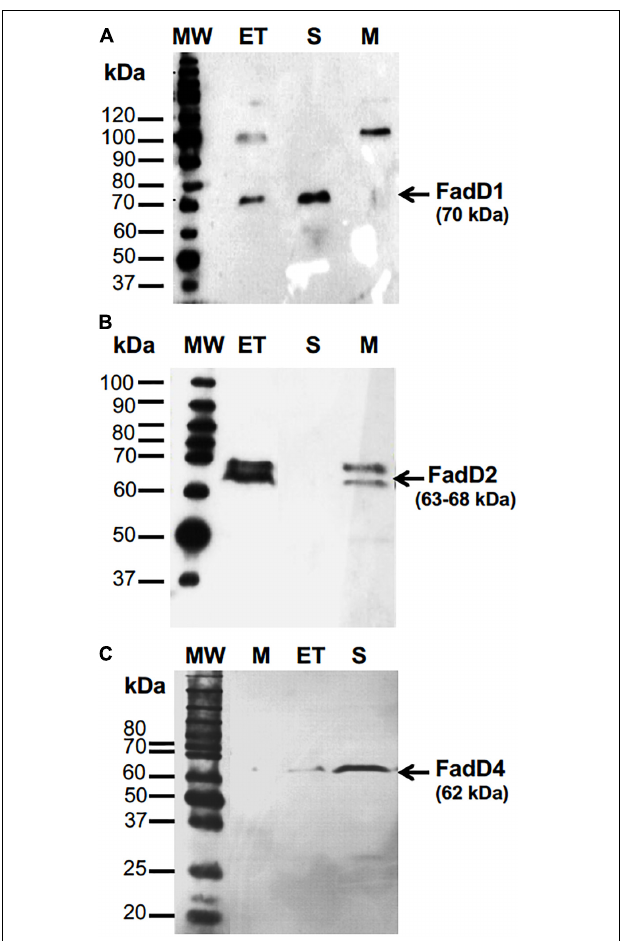
FIGURE 4 | The expression of recombinant FadD1, FAdD2, and FadD4 proteins of P. aeruginosa PAO1 in E. coli . Purification and western blot analysis of (A) FadD1, (B) FadD2, and (C) FadD4. Western blot detection used anti-His antibody. MW, molecular mass marker; ET, cell-free protein extract; S, soluble fraction; M, membrane fraction. Protein molecular weight markers in kilodaltons are indicated.